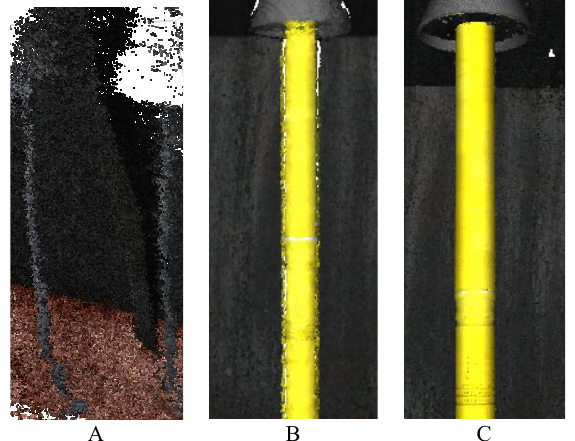
Figure 11. Deviation maps of the reconstructed riser to GT for trajectories “B” and